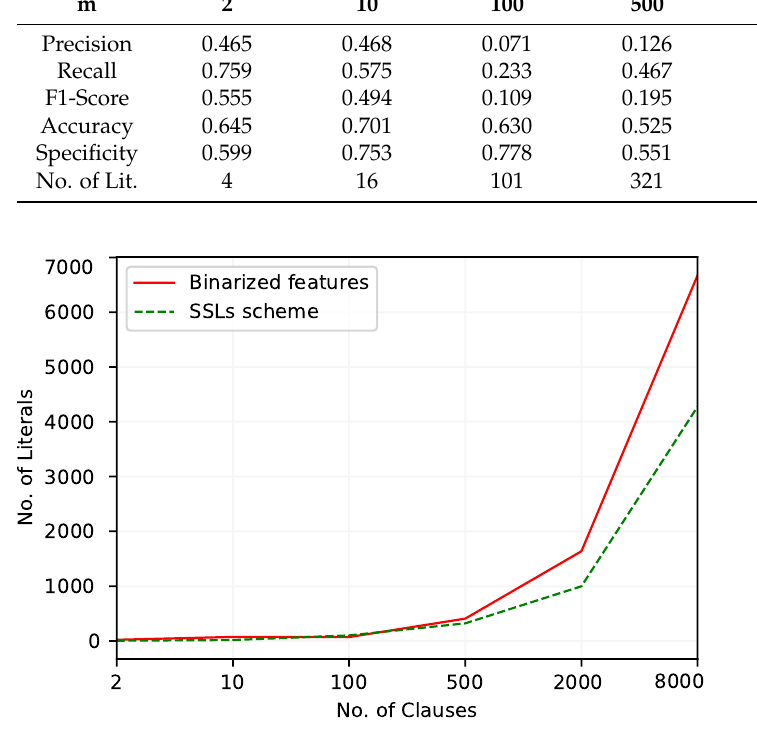
Figure 5. The number of literals included in TM clauses to work with Breast Cancer